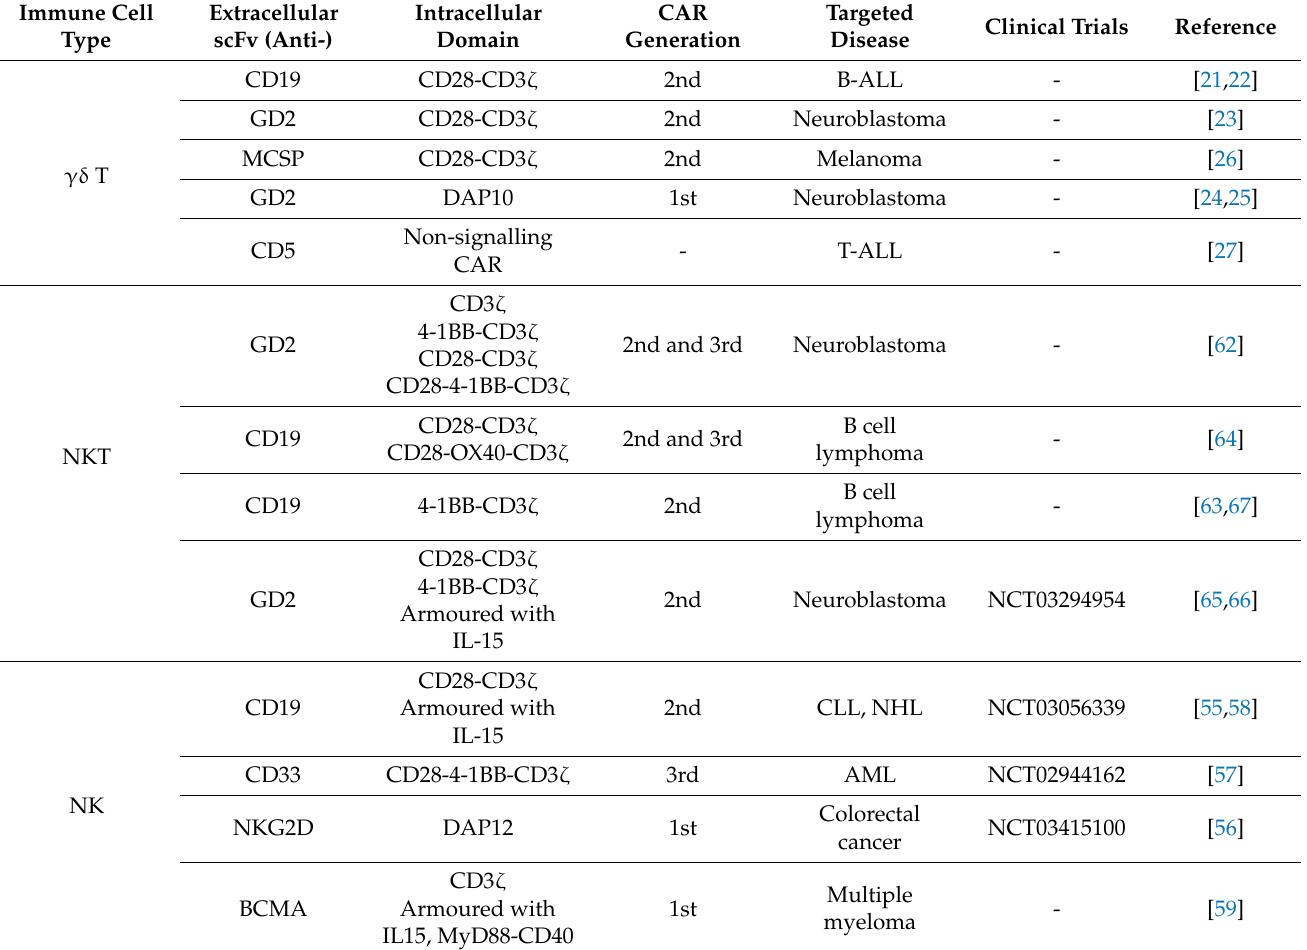
Table 1. The CAR designs are different in non-conventional T cells and other immune cell subsets. Immune